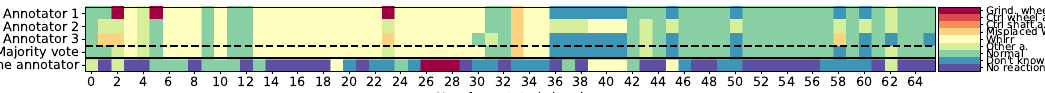
Figure 10. Qualitative evaluation of agreement between multiple retrospective annotators and with online label feedback for signals proposed as anomaly (cf. Assumptions 3a and 3b). While annotators show high agreement during retrospective annotation, agreement between in situ online label feedback (row 5) and the majority vote of retrospective annotations (row 4) is low.